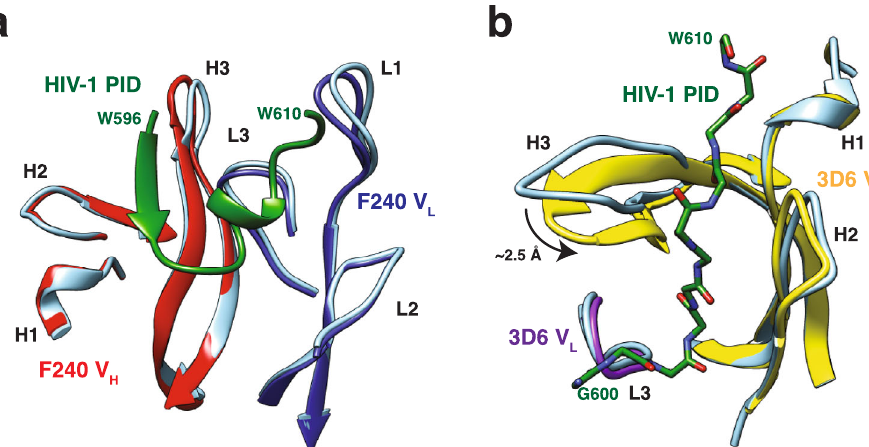
Fig. 4 Lock-and-key mechanism of interaction of PID with Fab F240. a Bound and unbound F240 superimpose with an 0.65 Å RMSD with 98.2% of equivalent positions overlapping, suggesting a lock-and-key mechanism of binding. b Conformational changes within Fab 3D6 CDR loops upon coordination of the PID peptide. 3D6 unbound and PID-bound structures superimpose with a 0.90 Å RMSD with 98.4% overlap. Ribbon diagrams of unbound Fabs are depicted in corn fl ower blue, whereas the PID is colored in the dark green, heavy chain in red, and light chain in dark blue.